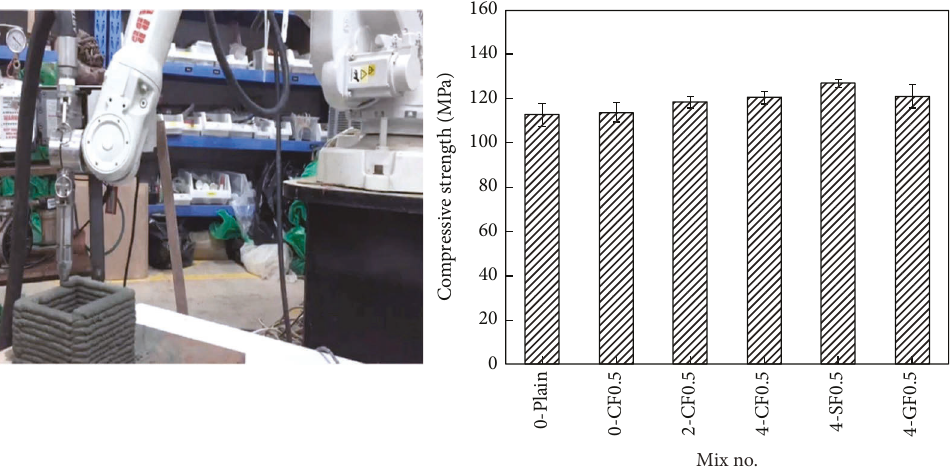
Figure 11: Shape and compressive strength of 3D printing concrete sample